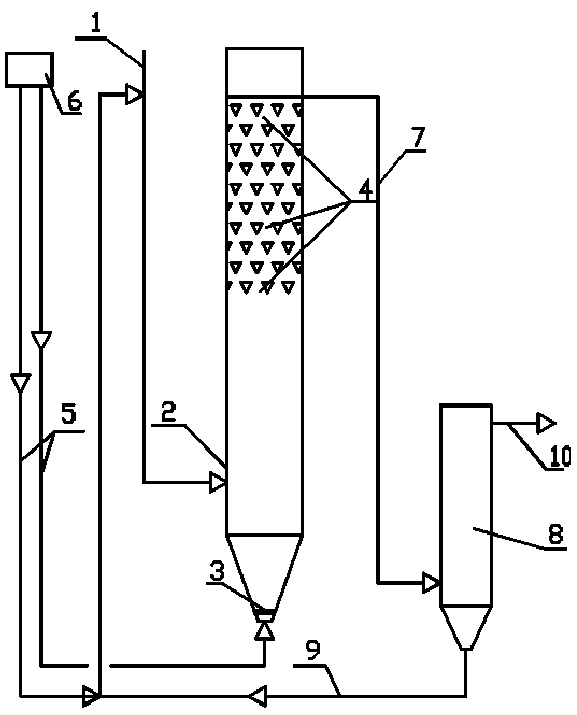
Figure 2. Scheme of the lab-scale bench: 1—wastewater influent; 2—aerobic reactor; 3—aeration device; 4—floating carrier; 5—air supply; 6—compressor; 7—effluent from reactor; 8—sedimenta-